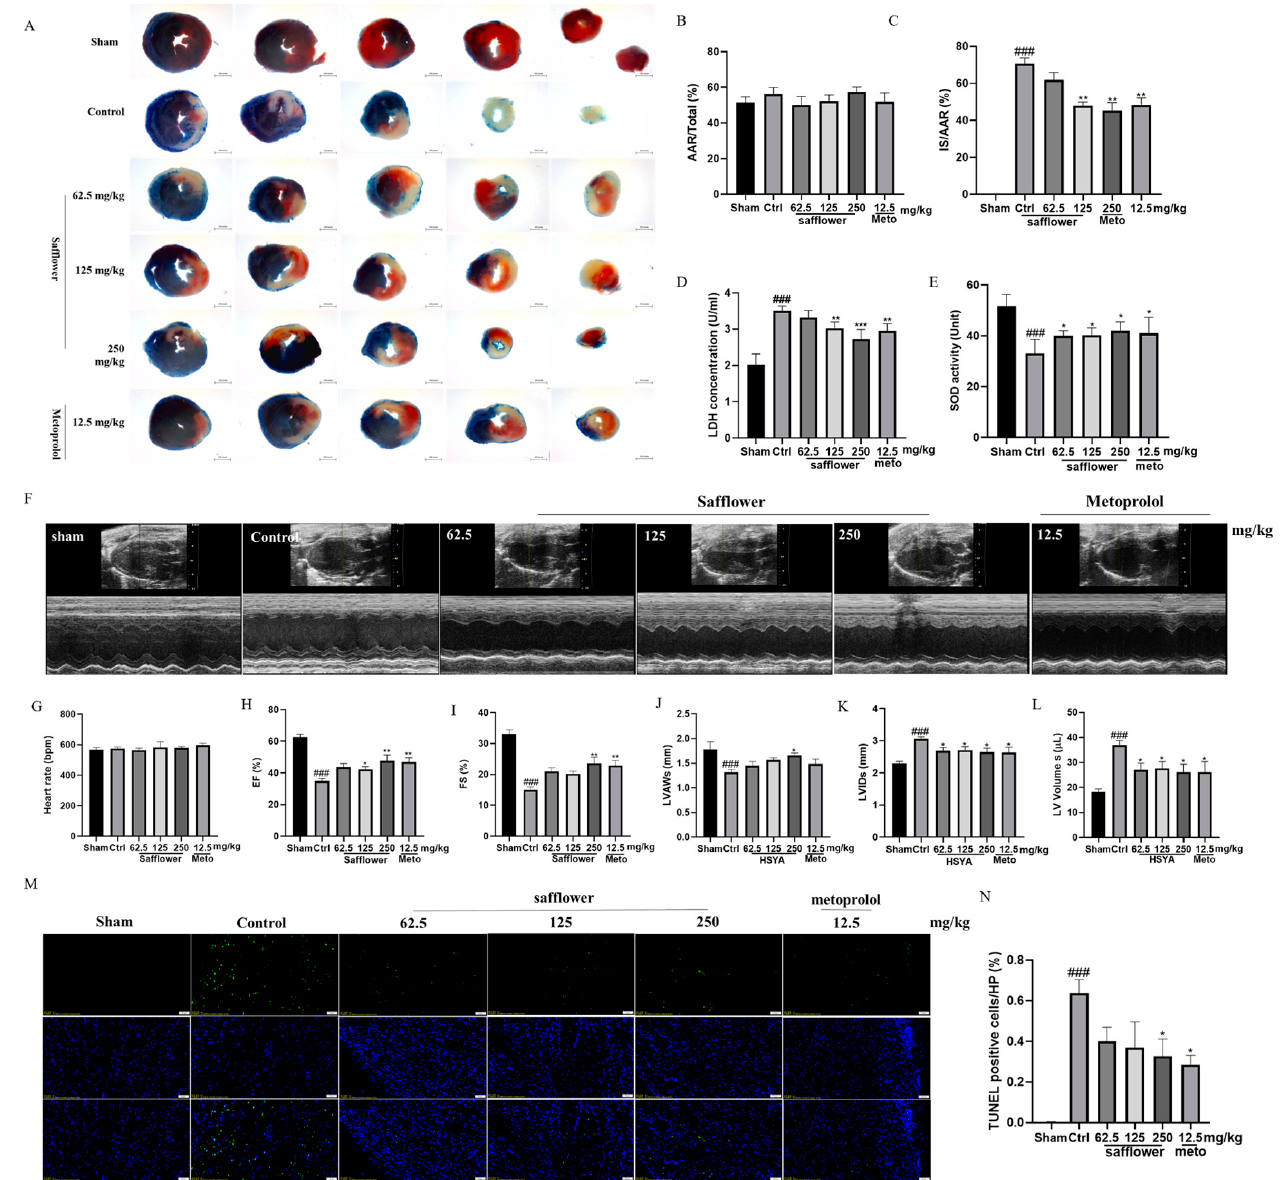
Figure 2. Pharmacodynamic studies of safflower effect on MI/R injury. Representative photographs of TTC/Evans blue perfused hearts were shown for sham, control, safflower treatment (62.5, 125, 250 mg/kg, 4 times/24 h) and metoprolol groups (12.5 mg/kg/24 h) ( A , scale bar is 200 pixels). Infarct size (IS) ( C ) and area at risk (AAR) ( B ) were quantified after MIR injury for 24 h ( n = 9). Representative echocardiograph depicted for sham, control, safflower treatment, and metoprolol treatment ( F ) ( n = 6). Rate ( G ), EF ( H ), FS ( I ), LVAWs ( J ), LVIDs ( K ), and LV Volume s ( L ) values were quantified. Average serum LDH ( D ) ( n = 6) and SOD ( E ) ( n = 6) activities in MIR injury mice assayed on reperfusion for 24 h. Representative photographs of TUNEL staining ( M , scale bar is 50 µ m) and the statistical diagram of quantification ( N ) were shown ( n = 3). One-way ANOVA with Tukey’s multiple comparison test. Values are means ± standard error of mean (SEM), ### p < 0.001 vs. sham, respectively; * p < 0.05, ** p < 0.01, *** p < 0.001 vs. control, respectively; one-way